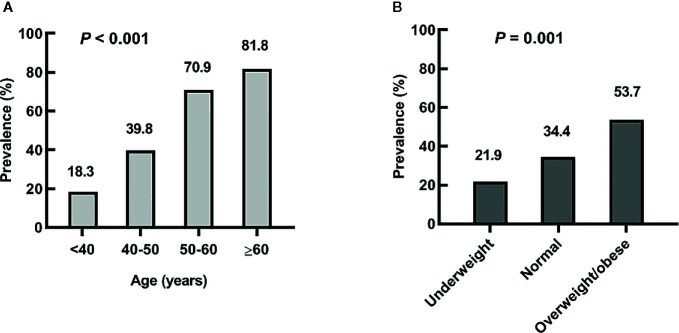
The prevalence of left ventricular diastolic dysfunction in overt hyperthyroidism patients grouped by age or body mass index (BMI). (A) The subjects were grouped by age; (B) The subjects were grouped by BMI categories.